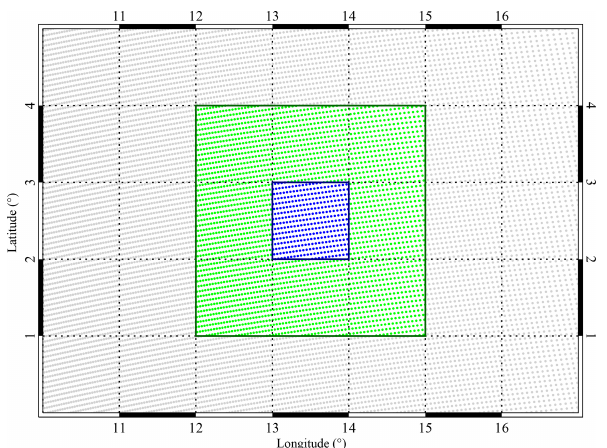
Figure 2. Illustration of the approach followed in this paper. The TROPOMI measurement footprints are represented by small dots. We focus, however, on the 1 ◦ × 1 ◦ latitude–longitude box in the middle. If the geometrical cloud fraction derived from the S5P NPP- VIIRS cloud information of the blue footprints is below 0.03, then the NPP-VIIRS geometrical cloud fraction is determined for the sur- rounding 3 ◦ × 3 ◦ latitude–longitude box. If this cloud fraction is be- low 0.05, then the middle box is considered cloud-free. If it is also considered aerosol free, then the TROPOMI reflectance spectrum is calculated for the middle box. This is done for each of the spectral bands. More detailed information is provided in the main